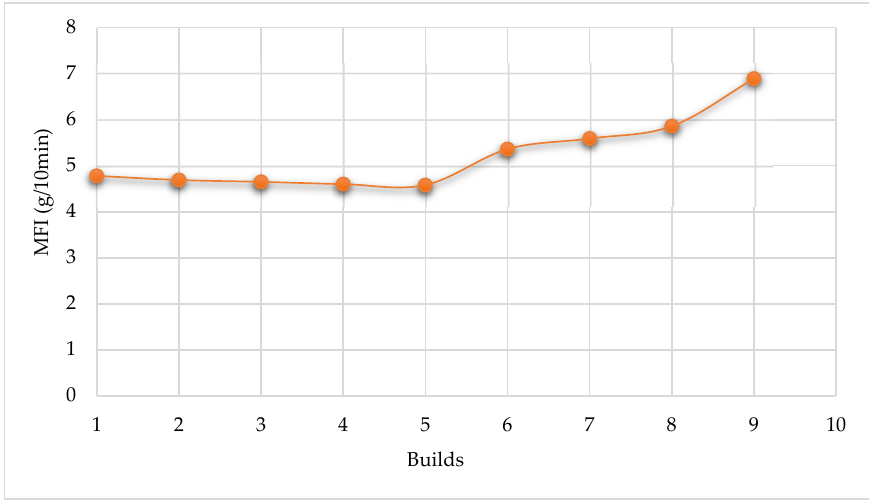
Figure 8. The trend of the MFI values up to nine builds.